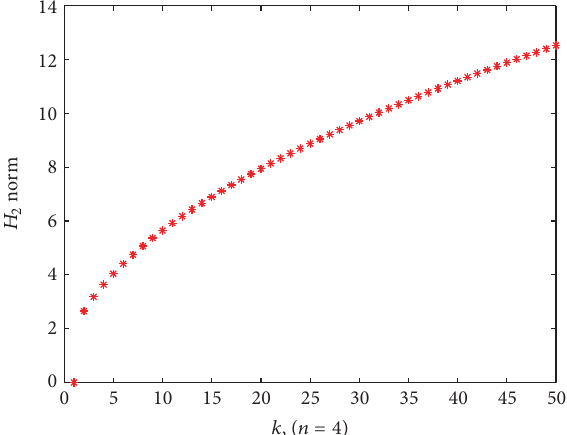
Figure 15: The variance of 𝐻 2 norm for 𝑆 3 ∘ 𝑃 𝑘 ( 𝑘 ≥ 2 ).